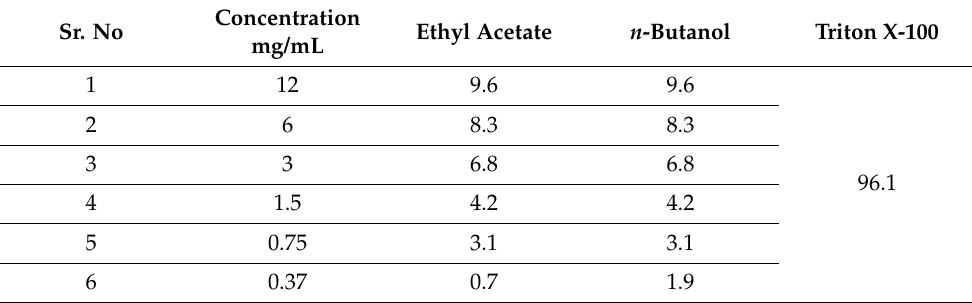
Table 6. Percentage hemolysis of fractions of T. vulgaris